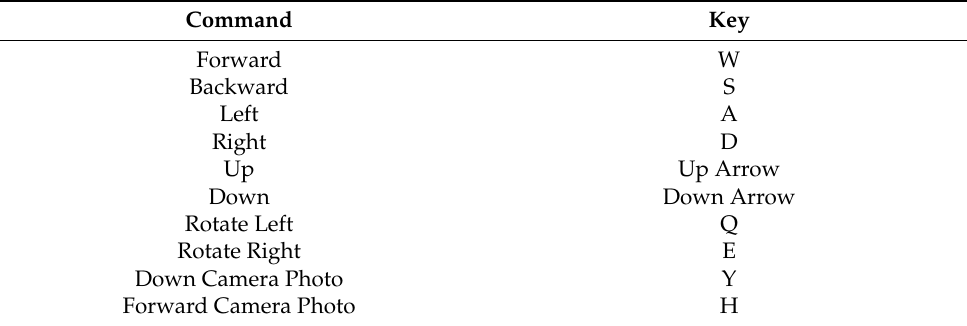
Figure 2. Simulation environment. Table 2. Command and keys to control of drone.